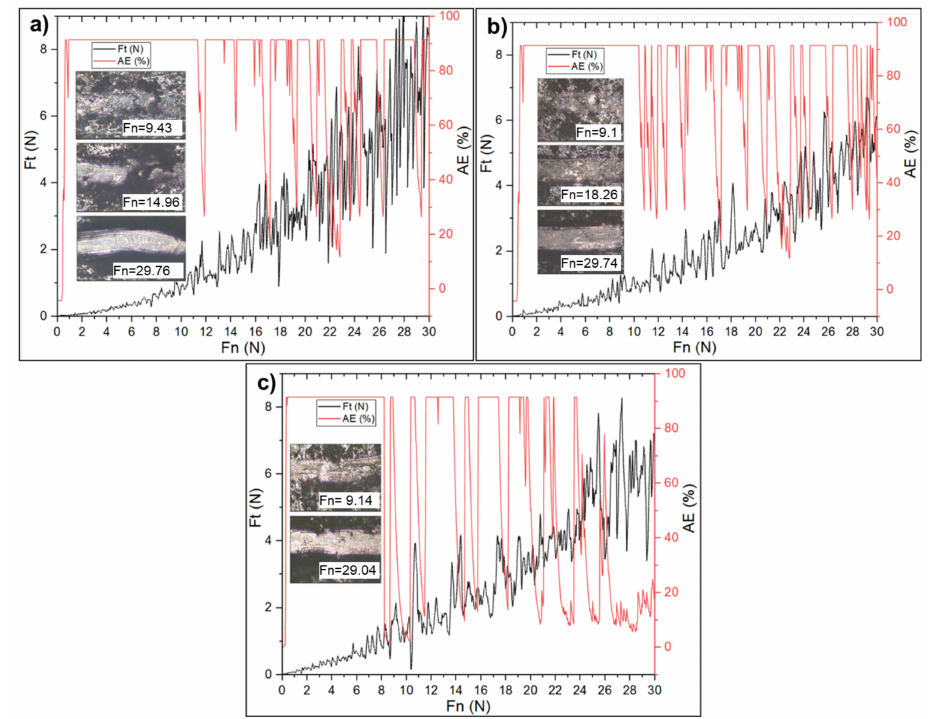
Figure 5. Results of the scratch test of Ti–Si–C coatings obtained at different filling volumes of the explosive gas mixture of the detonation gun barrel: ( a ) 50%, ( b ) 60%, and ( c )